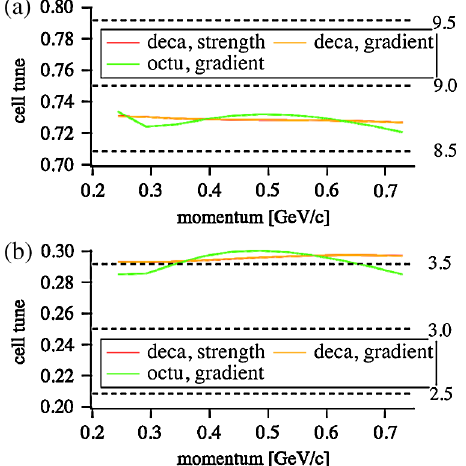
FIG. 11. (Color) Cell tunes throughout acceleration for the case of rectangular-shaped magnets with polynomial fit to either strength or gradient of scaling field. Three magnets are aligned parallel with each other. Horizontal cell tune in (a) and vertical cell tune in (b). Dashed lines and associated numbers show total tune of a 12 cell ring. In both (a) and (b) the difference between the two decapole cases is too small to be visible at this